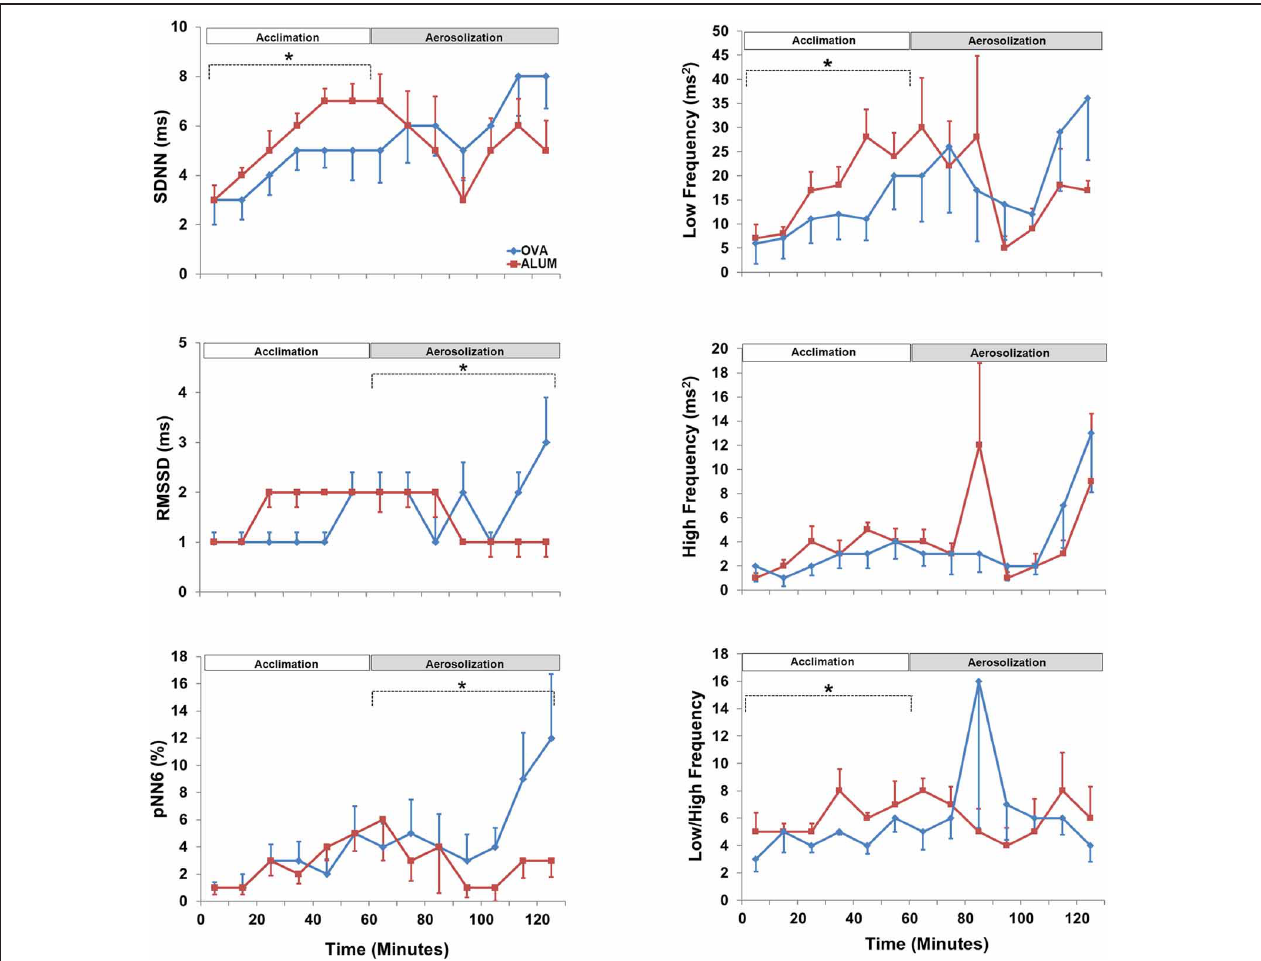
FIGURE 4 | Heart rate variability prior to and during aerosol challenge. The acclimation control period (0–60min) and aerosol challenge (70–130min, to accommodate sampling) were independently analyzed by Two-Way ANOVA and Holm-Sidak post-hoc analyses; ∗ P < 0 . 05. During acclimation,